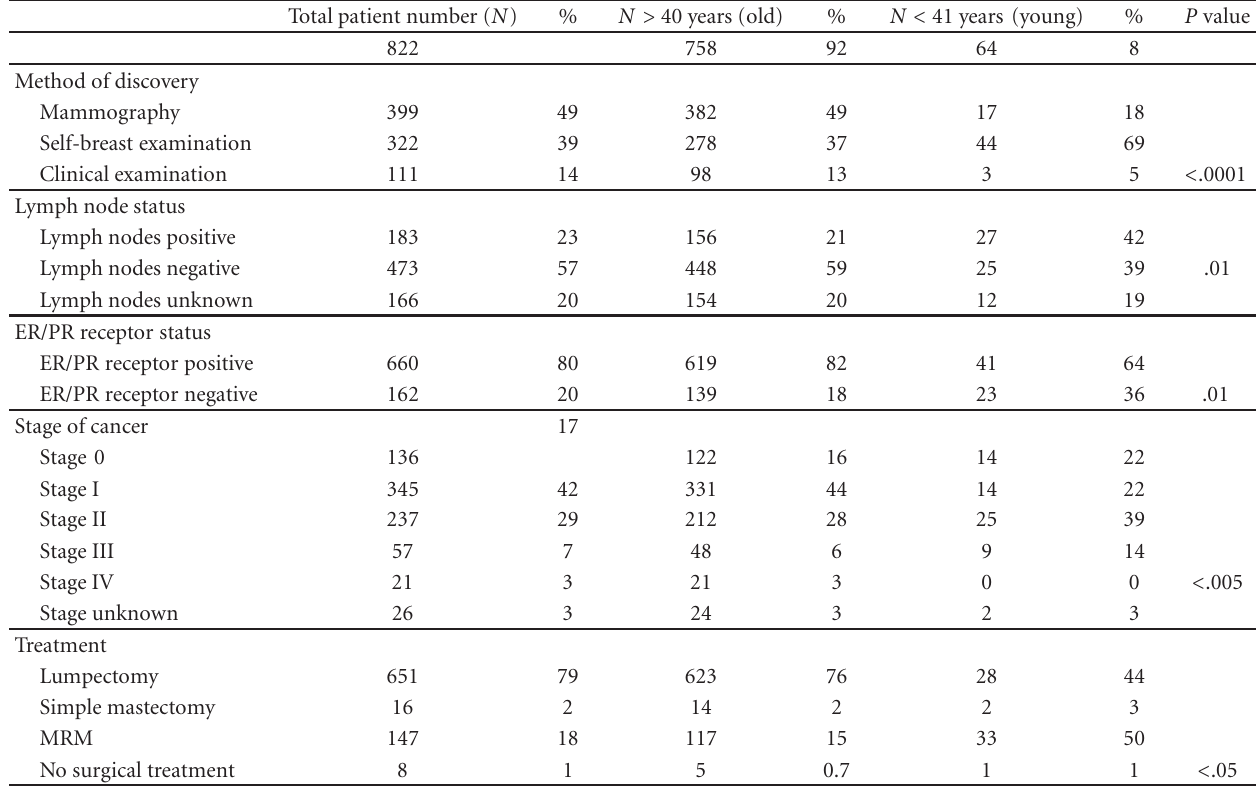
Table 1: Data comparing younger and older breast cancer